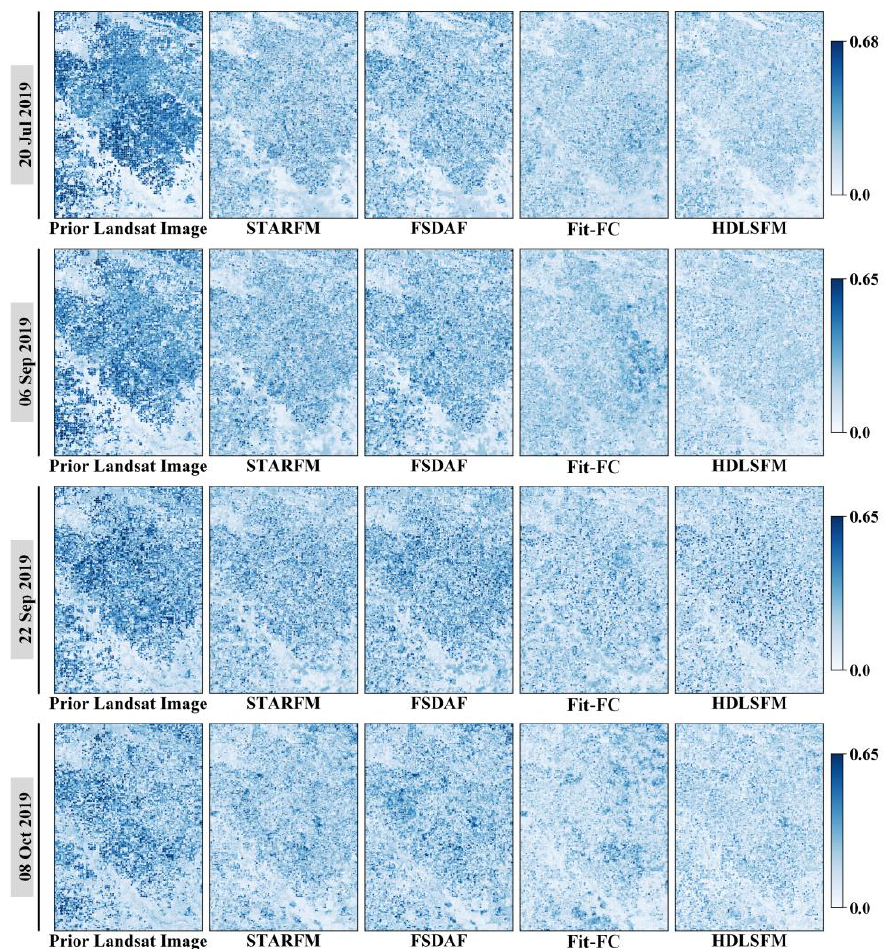
Figure 13. Average AAD maps of the actual image and prediction results of the SWK